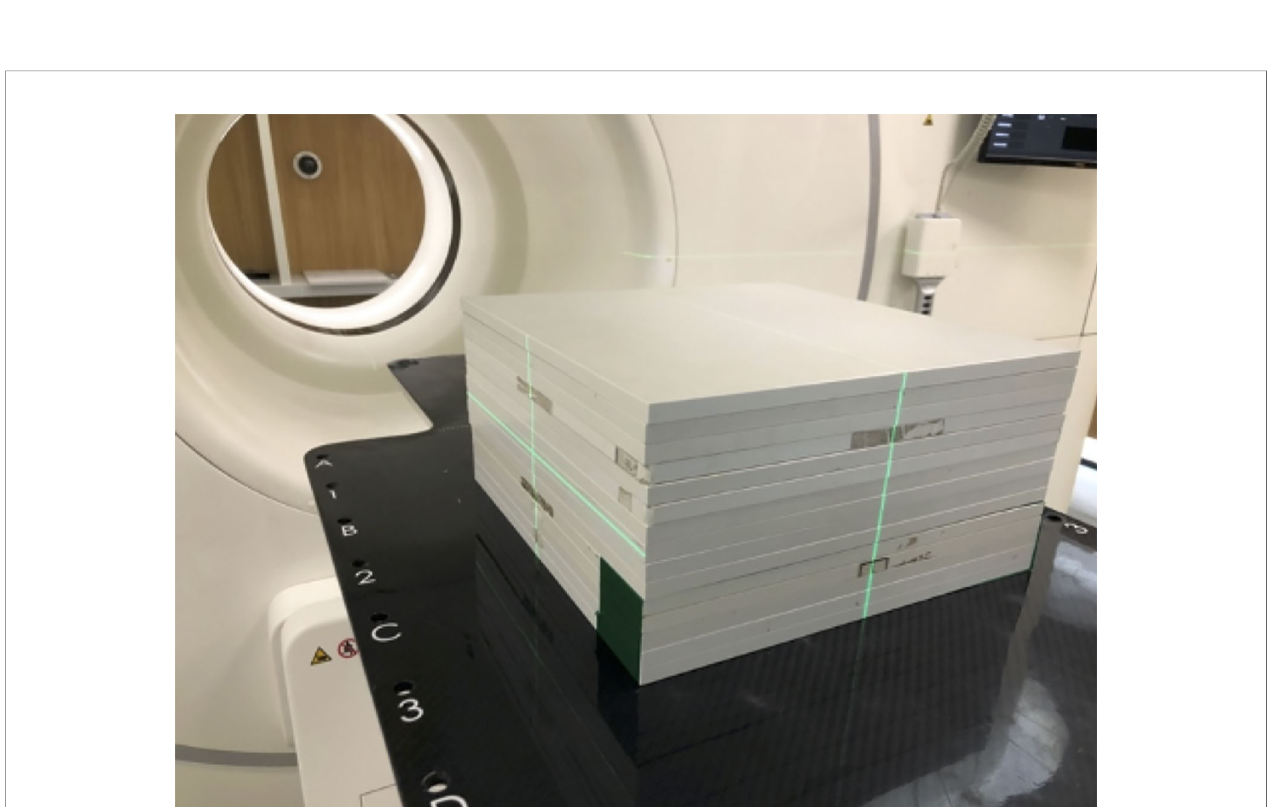
FIGURE 4 | The quality assurance (QA) phantom, the RW3 slab phantom (PTW, Freiburg).